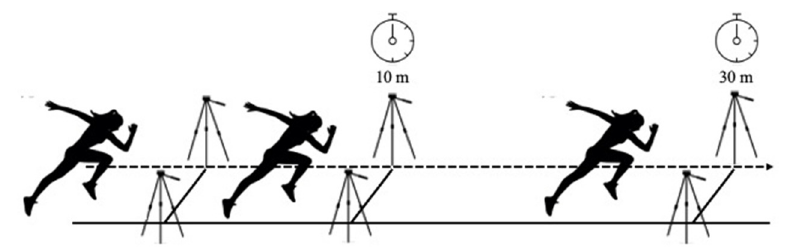
Figure 4. Acceleration evaluations at 10 m and velocity at 30 m.